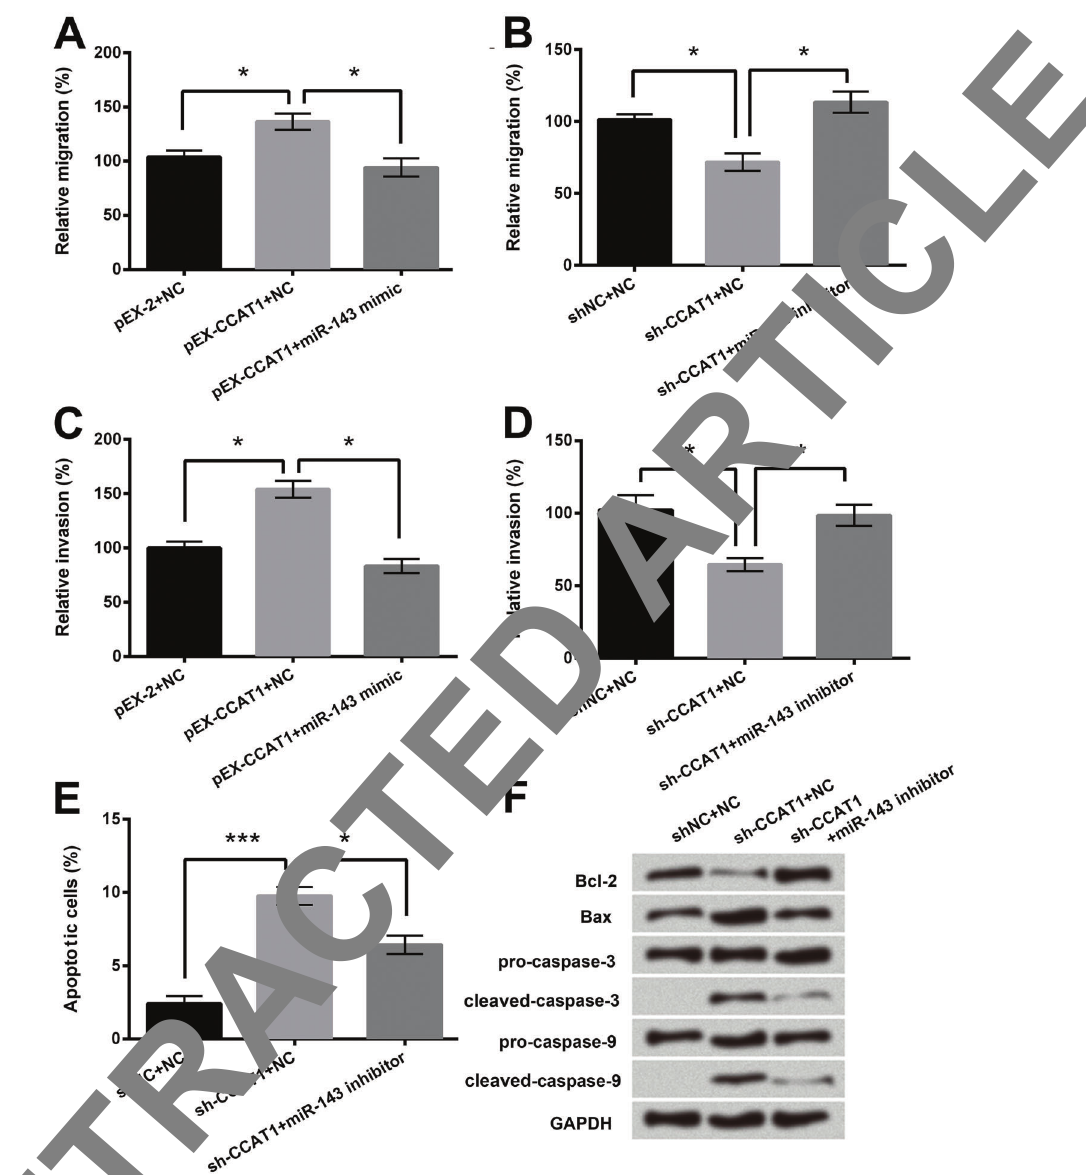
Figure 5. CCAT1 enhanced cell migration and invasion via the inhibition of miR-143. FTC-133 cells were transfected with CCAT1 expressing vector, CCAT1 shRNA, miR-143 mimic, or miR-143 inhibitor. A and B , Cell migration, C and D , invasion, and ( E ) apoptosis were measured in FTC cells using Transwell assay, invasion assay, and fl ow cytometry analysis, respectively. F , The expressions of apoptosis-related proteins were detected using western blot analysis. NC: negative control. Data are reported as means ± SD. *P o 0.05, ***P o 0.001